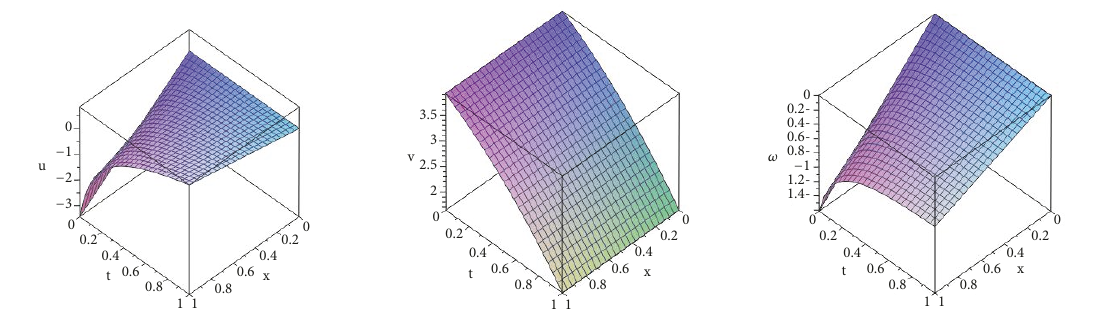
Figure 14: Surface of 𝑢 , V , and 𝜔 for 𝑀 = 1 , 𝑆 = −14 , 𝛾 = 0 . 4 , 𝑦 = 1 , 𝛼 = −3 , 𝑙 = 2 .